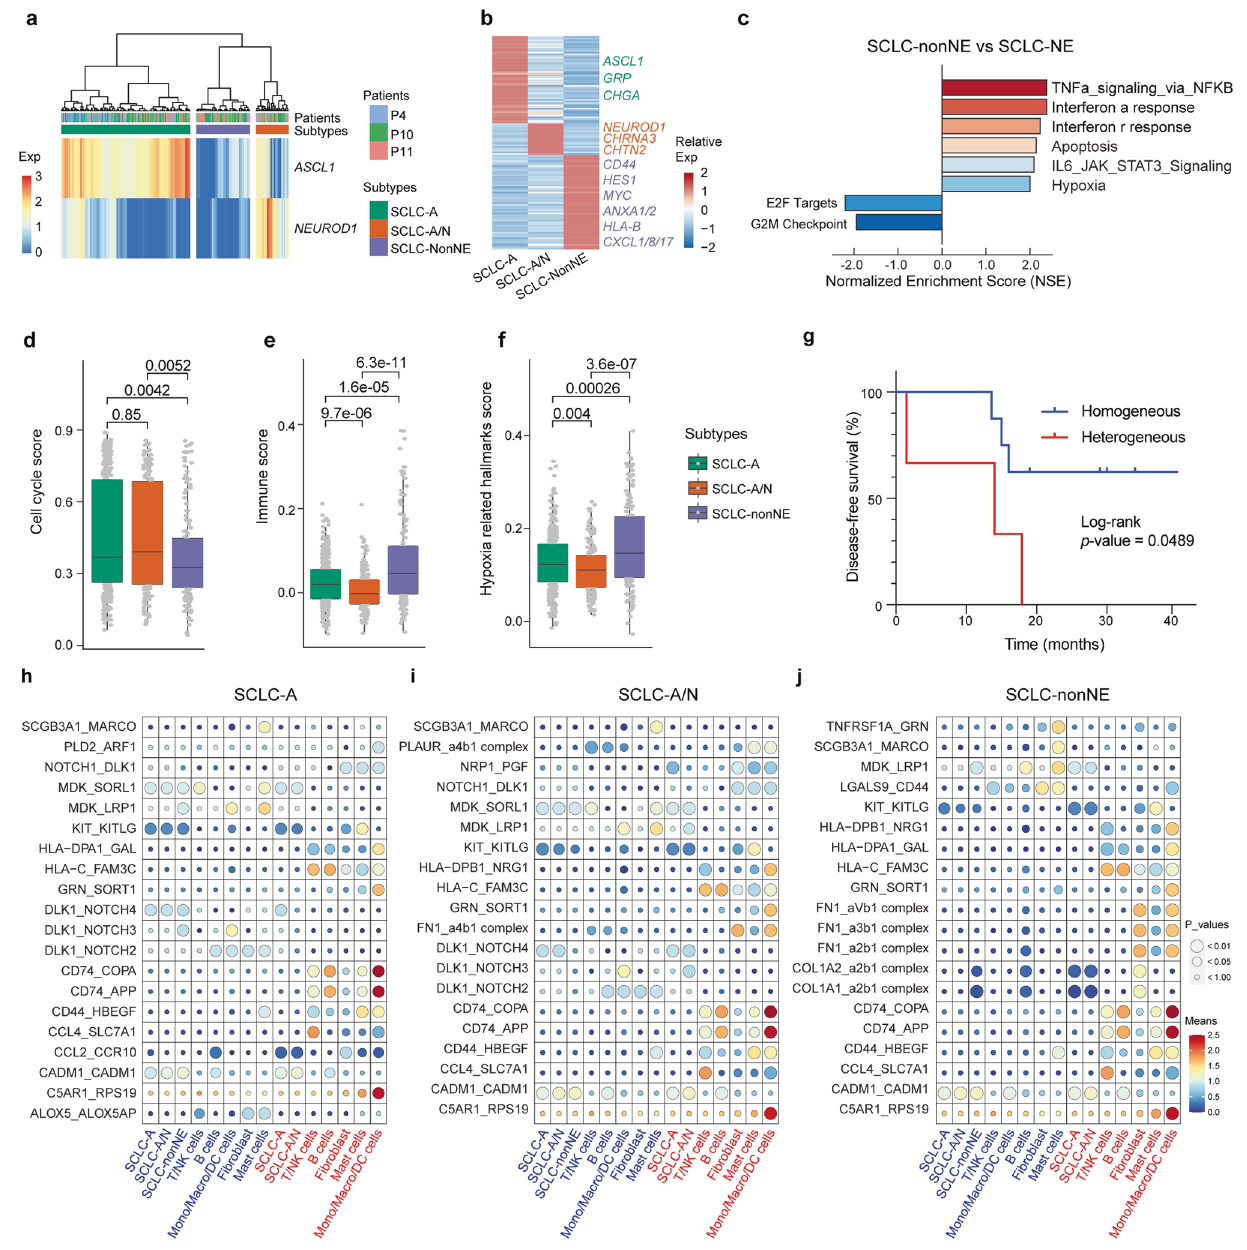
Fig. 5 Inter/intratumor heterogeneity of the subtypes of SCLC de fi ned by the expression levels of ASCL1 and NEUROD1 . a Hierarchical clustering of ASCL1 and NEUROD1 expression in malignant cells from P4, P10 and P11 revealed three main clusters. b Heatmap shows the DEGs among the three clusters, with interesting genes indicated in corresponding colors. c GSEA was performed to interpret gene expression data from the SCLC-non-NE cluster compared with the SCLC-NE cluster (including SCLC-A and SCLC-A/N). d – f Scores of the three subtypes regarding the cell cycle- ( d ), immune- ( e ) and hypoxia-related ( f ) hallmarks described in Fig. 2. The boxes display the interquartile range (IQR = Q3 – Q1; the 25th (Q1) to the 75th percentiles (Q3)), with the centerline denoting the median. Whiskers were drawn to represent Q1 minus 1.5 × IQR and Q3 minus 1.5 × IQR. All other observed points are plotted as outliers. Dots were added to box plots using the function geom-dotplot. Statistical analyses were performed using one-way ANOVA followed by Bonferroni ’ s multiple comparisons test, with the p - values indicated. g Disease-free survival (DFS) was analyzed by the comparison of 3 SCLC patients (heterogeneous) to 6 other SCLC patients (homogeneous). The log-rank test was performed to indicate a difference with a p -value of less than 0.05. h – j Dot plots derived from CellPhoneDB show selected ligand – receptor interactions (top 20 based on the expression level) from SCLC-A ( h ), SCLC-A/N ( i ) and SCLC-non- NE ( j ) clusters with other clusters or cell types. The size of the circle represents the p -values. The means of the average expression level of interacting pairs are indicated by color. The cell clusters labeled blue and red on the ‘ x ’ -axis indicate that they act as receptors and ligands in the interaction pairs, respectively (Fig. 7a), which were termed as ‘ immune hot ’ , and half expressing according to the key TFs ASCL1 , NEUROD1 , POU2F3 and YAP1 weak immune characteristics ( ‘ immune cold ’ ). “ Immune hot (Supplementary Fig. S8a). The immune signature of these cell lines tumors ” refer to immune cell well-in fi ltrated tumors, whereas revealed a heterogeneous intertumor immune pro fi le, with half “ Immune cold tumors ” refer to immune cell poorly- or non- (25/50) of the cell lines expressing strong immune characteristics Signal Transduction and Targeted Therapy (2022)